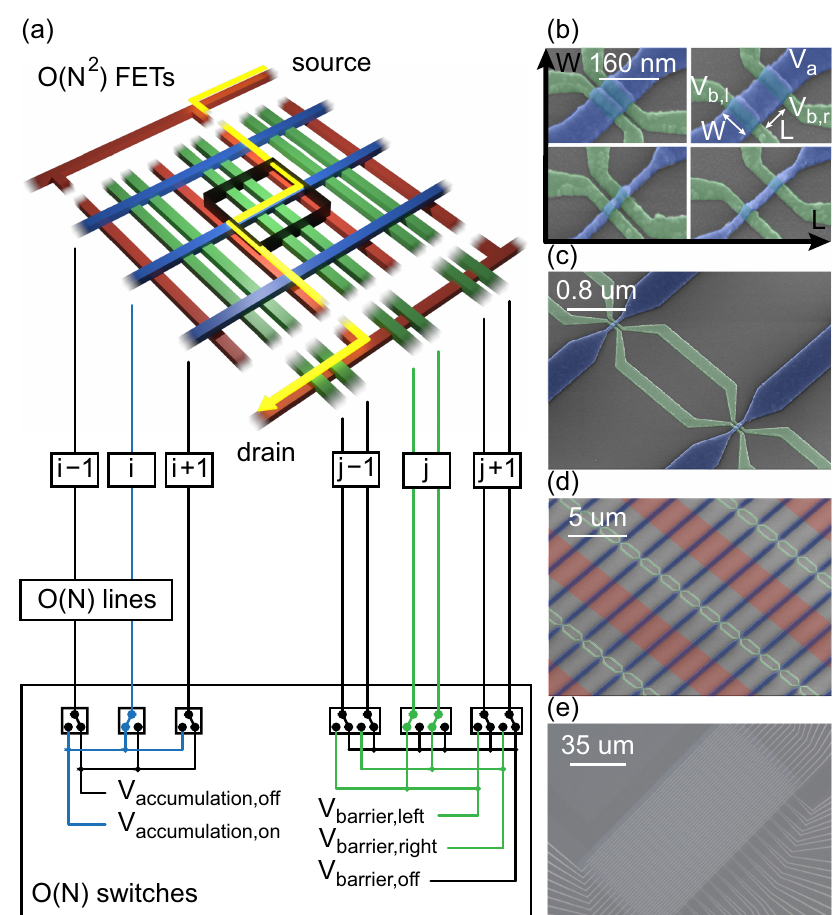
Fig. 1 Crossbar design and schematic operation. a Schematic representation of the quantum dot crossbar connected to cryo-CMOS multiplexing control circuitry. A sub-group of 3 × 3 unit cells hosting multi-gate fi eld effect transistors (FET) is shown (top panel), with interleaved implant regions for source/drain ohmic contacts ( n ++ , red), rows of accumulation gates (AG, blue) to de fi ne a conductive channel, and columns of barrier gates (BG, green) to tune transport into the single electron regime. Indices i and j correspond to AG rows and BG pair columns across the crossbar array. Cryo-CMOS multiplexers on a printed circuit board (bottom panel) are used to route voltage biases and select the desired AG row and BG column, thereby creating a unique current path (yellow arrow) through a single unit cell (indicated by the black border) comprising one AG and two BGs and identi fi ed with index pair ( i , j ). With a linear increase in wires and switches, the number of measurable FETs scales quadratically. b False-colored scanning electron microscope (SEM) micrographs of four FETs, with the maximal variations of the AG width W and the distance between BGs L . These FETs are located at the four corners of a 36 × 36 electrode crossbar fabricated on a 28 Si/SiO 2 stack. The AG and BGs are represented in blue and green, respectively. c Two FETs with shared barrier gates, featuring gate widening to aid lift-off. d Zoomed-out SEM of multiple unit cells, including implanted ohmics represented in red. e Optical microscope image of the crossbar featuring 648 multi-gate FETs and 1296 crossings between AG and BG with contact fan-out